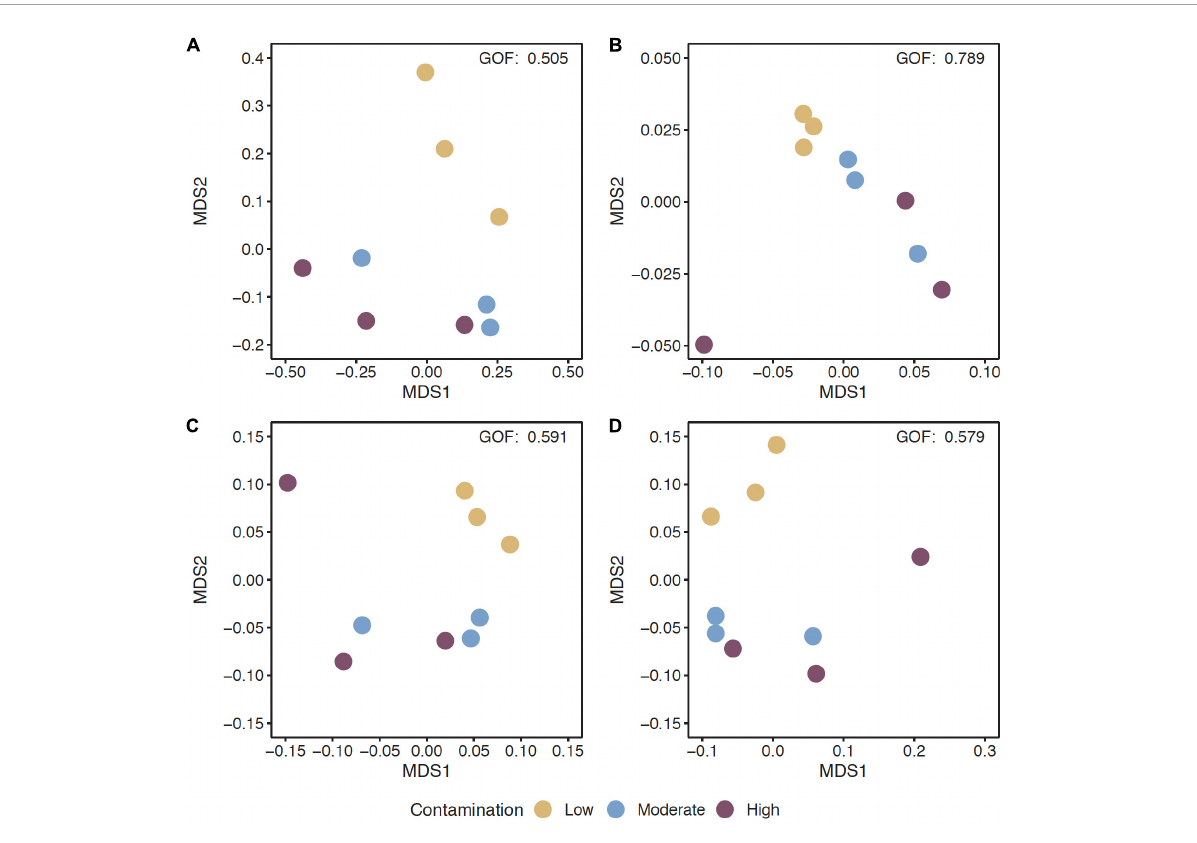
FIGURE1 Non-metric multidimensional scaling (MDS) ordination of functional beta-diversity of all predicted genes (A) and of genes of the EggNOG database (B) , the CAZy database (C) , and the NCyc database (D) at sites with the three Hg contamination levels (low, moderate, high).